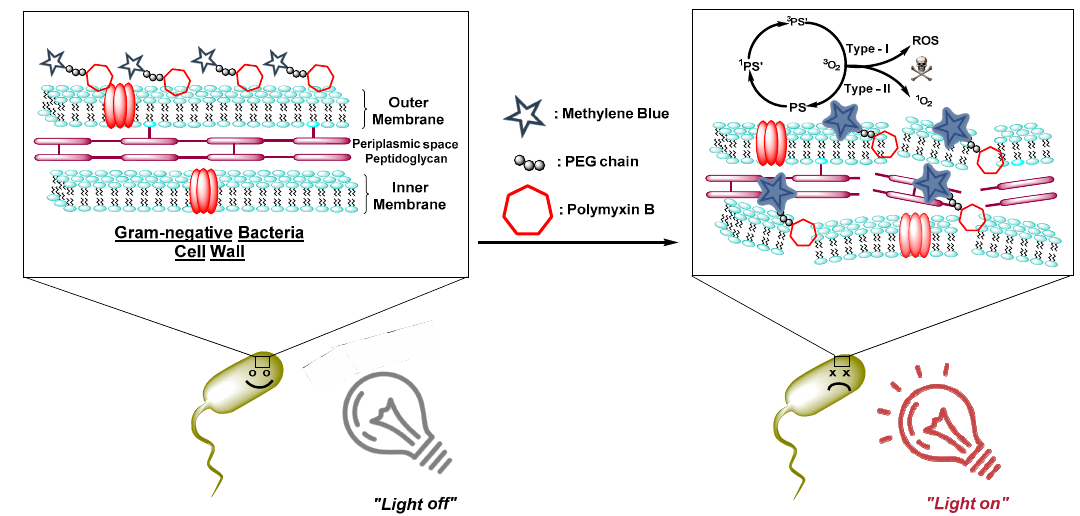
Figure 6. Illustration of the targeted aPDT treatment of Gram − bacteria with the Polymyxins (PMX)- methylene blue (MB) conjugate, during which the PMX cyclopeptide binds to the pathogen membrane and ROS are generated once the light is switched on—an example of entropically driven aPDT.